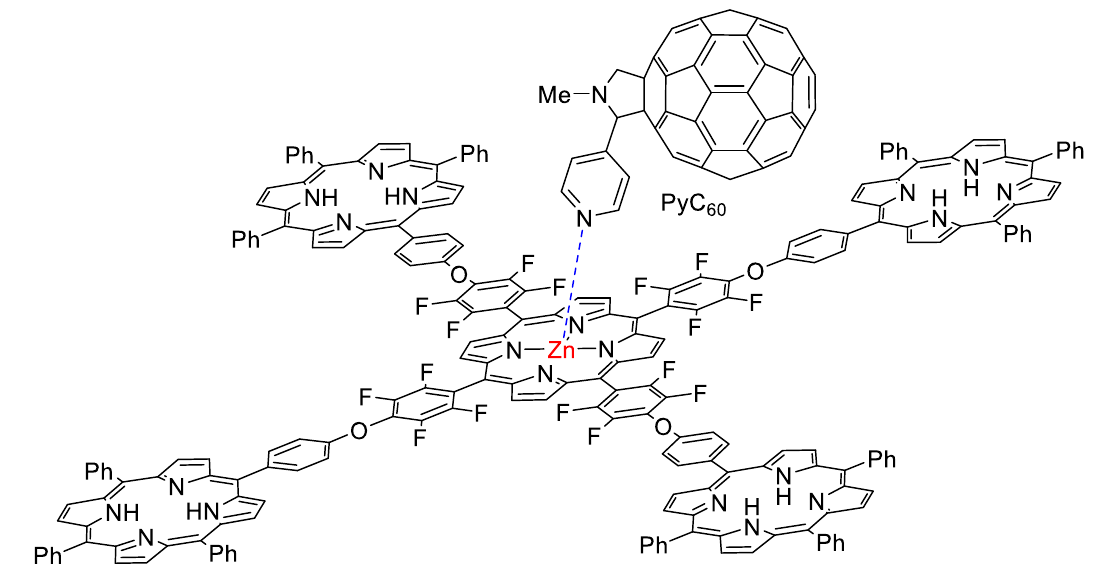
Figure 5. Representation of the coordination complex 6 – PyC 60 .